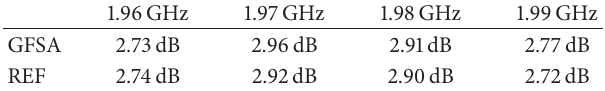
Table 1: LHCP gains of GFSA and